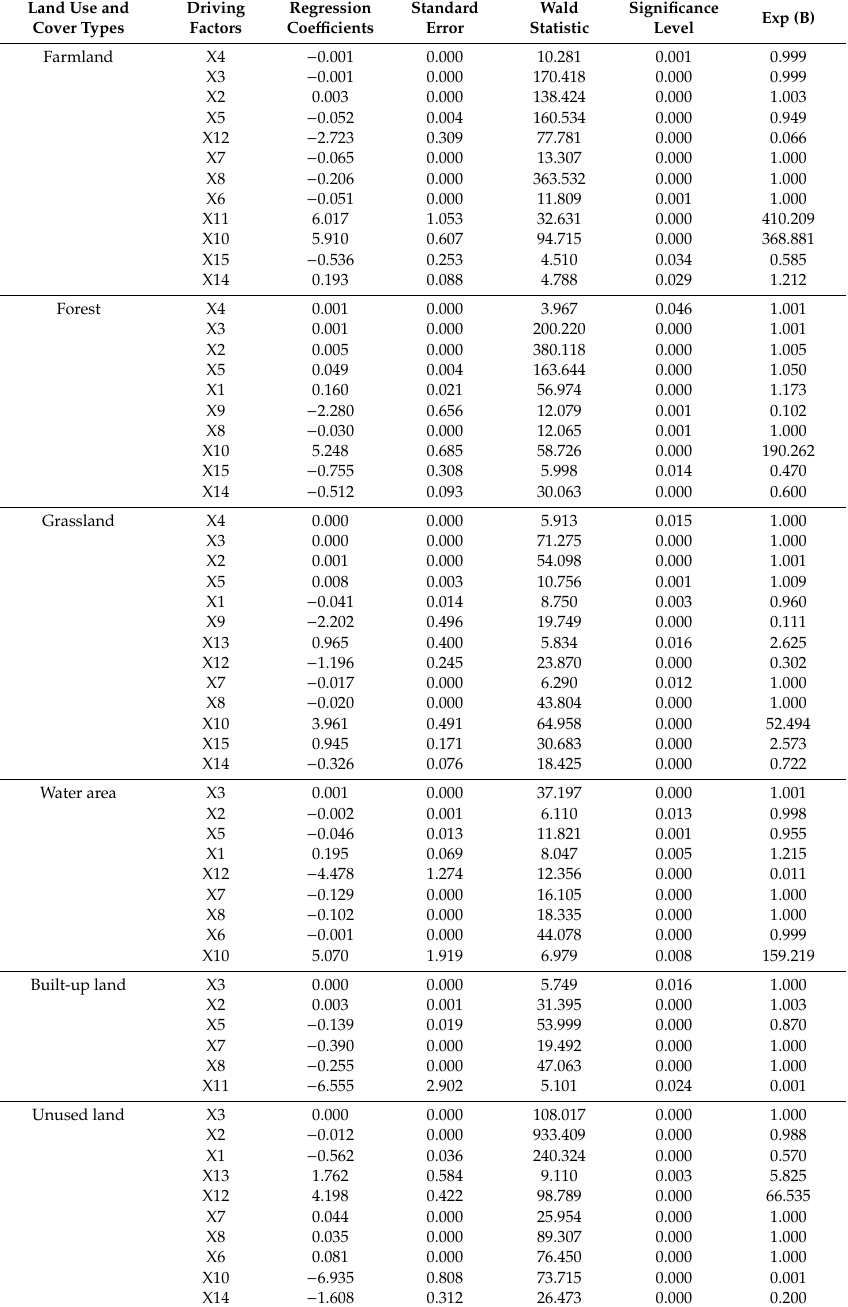
Table 6. Results of binary logistic regression